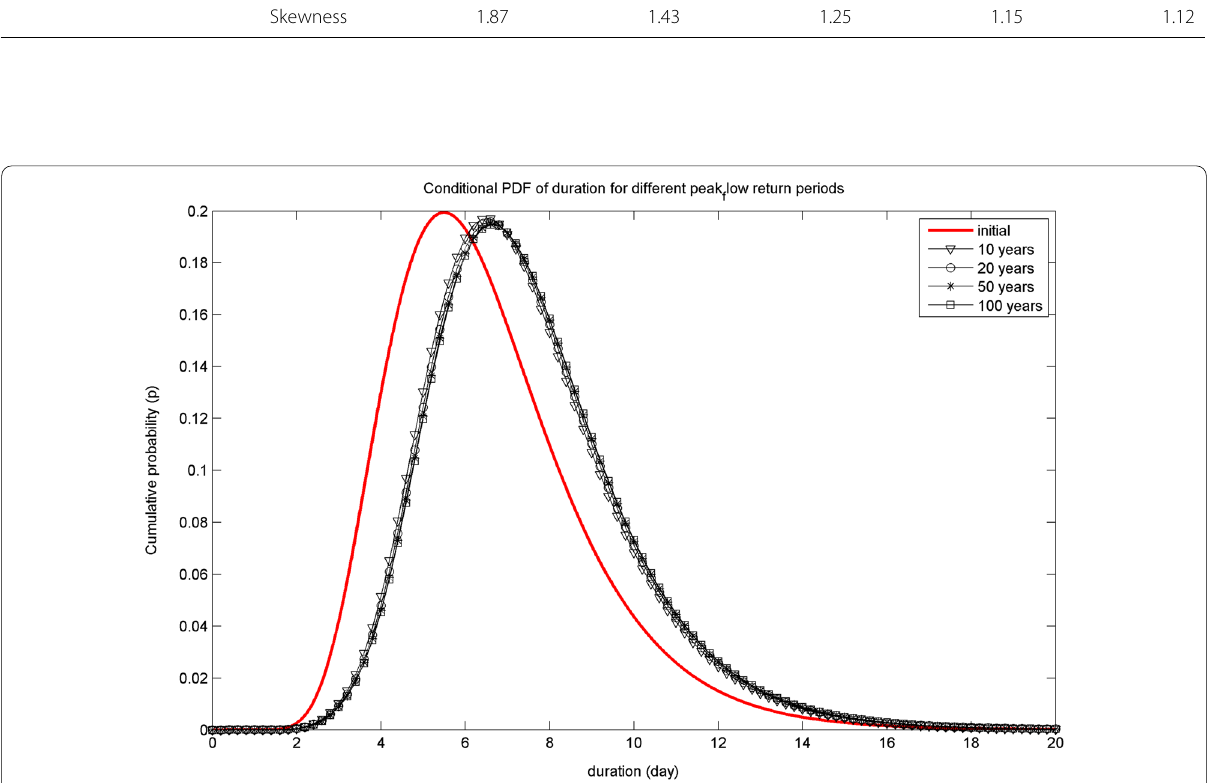
Fig. 14 Probability density functions of duration under different peak flow return